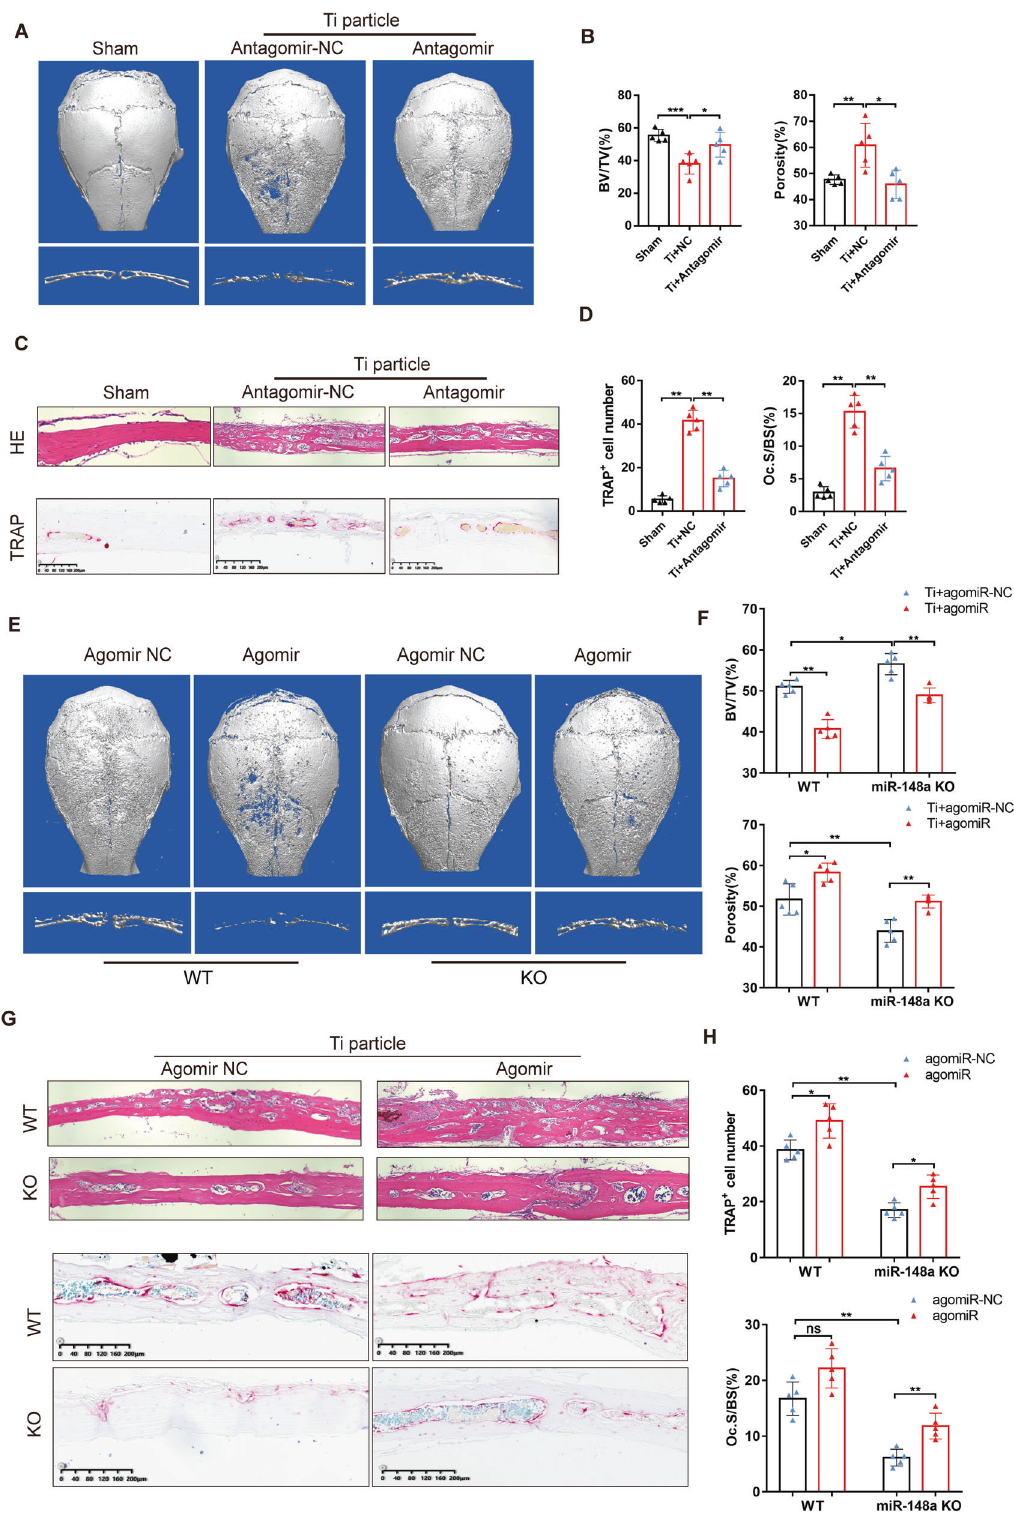
were inhibited in miR-148a KO mice, as evidenced by TRAP staining (Fig. 7G, H). Collectively, we propose that miR-148a KO inhibits osteoclast formation and ameliorates bone loss by regulating the NRP1 signaling axis in an OVX-induced osteoporosis